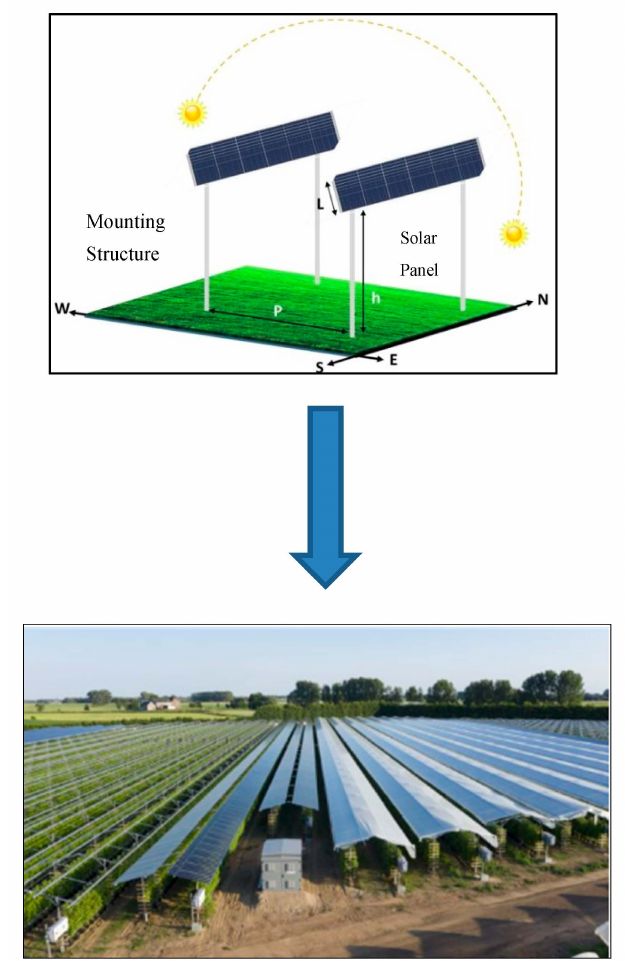
Figure 1. Basic components of agrivoltaic